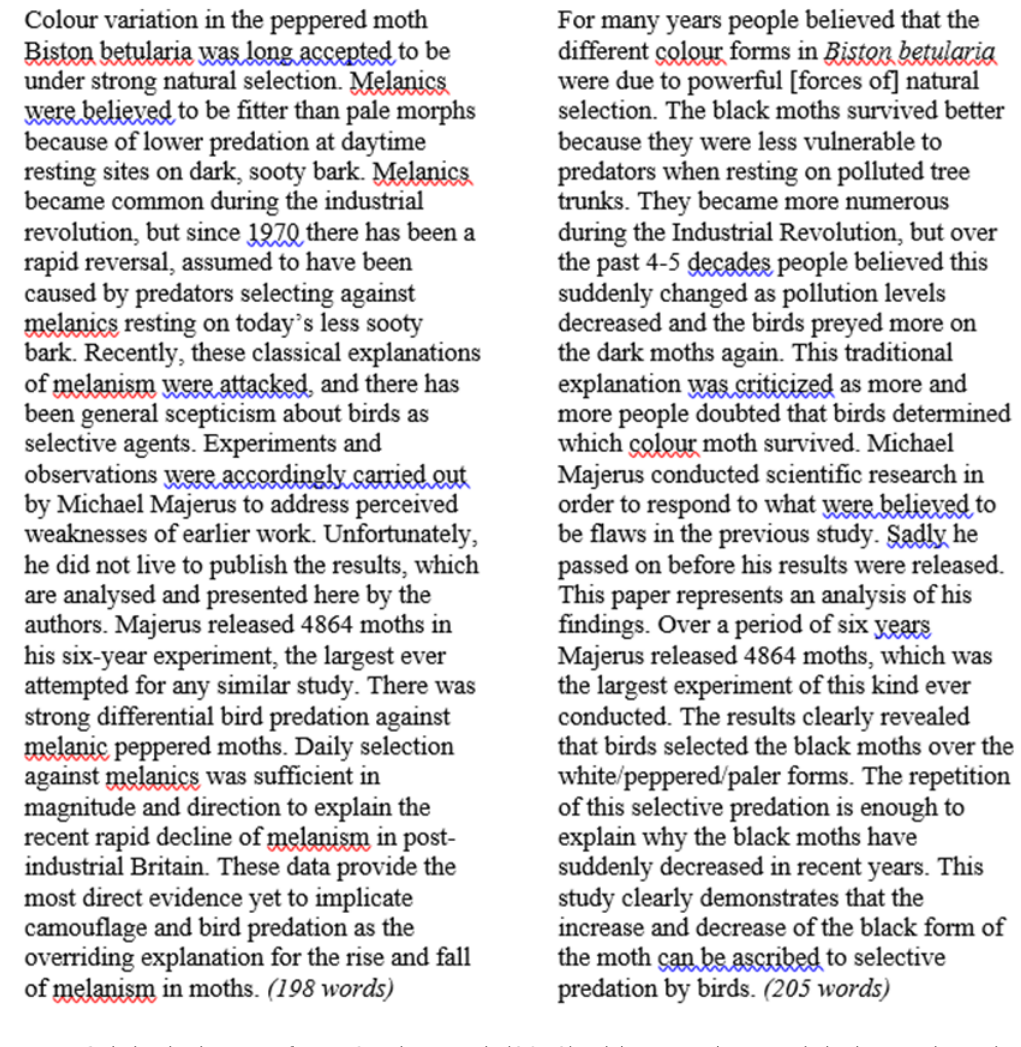
Figure 1 : Original Abstract from Cooke, et al. (2012) with new Abstract jointly rewritten by